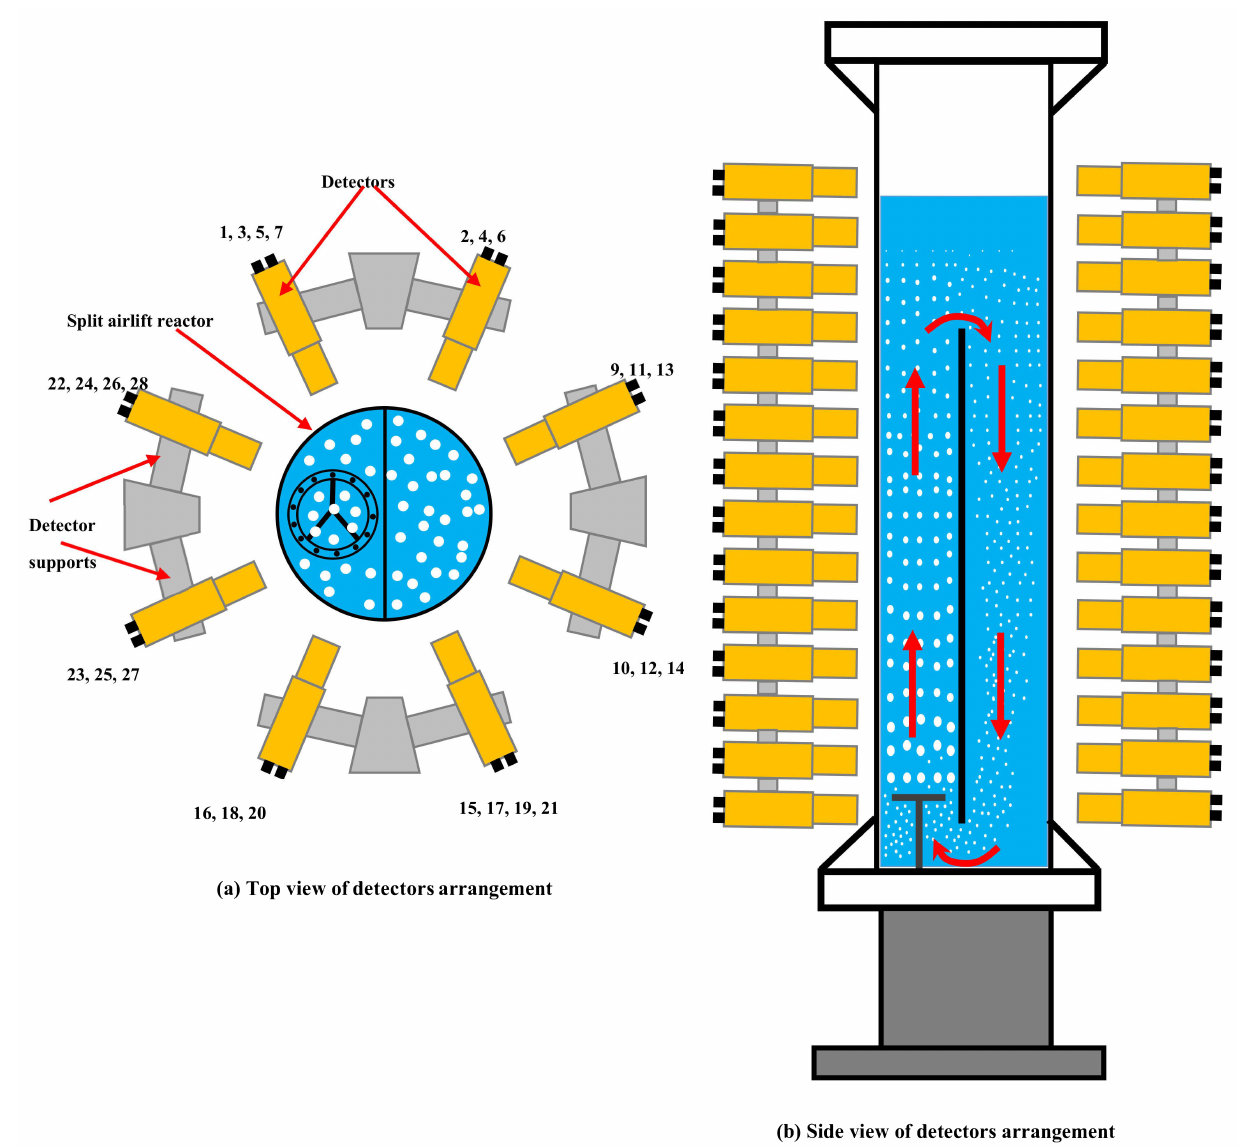
Figure 5. Schematic diagram of detectors arrangement around the split airlift